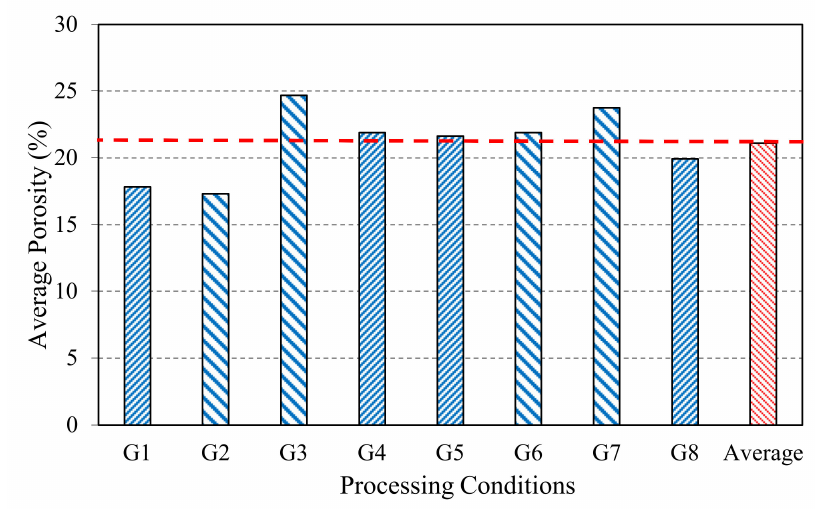
Figure 7. Average grade of porosity for the di ff erent processing